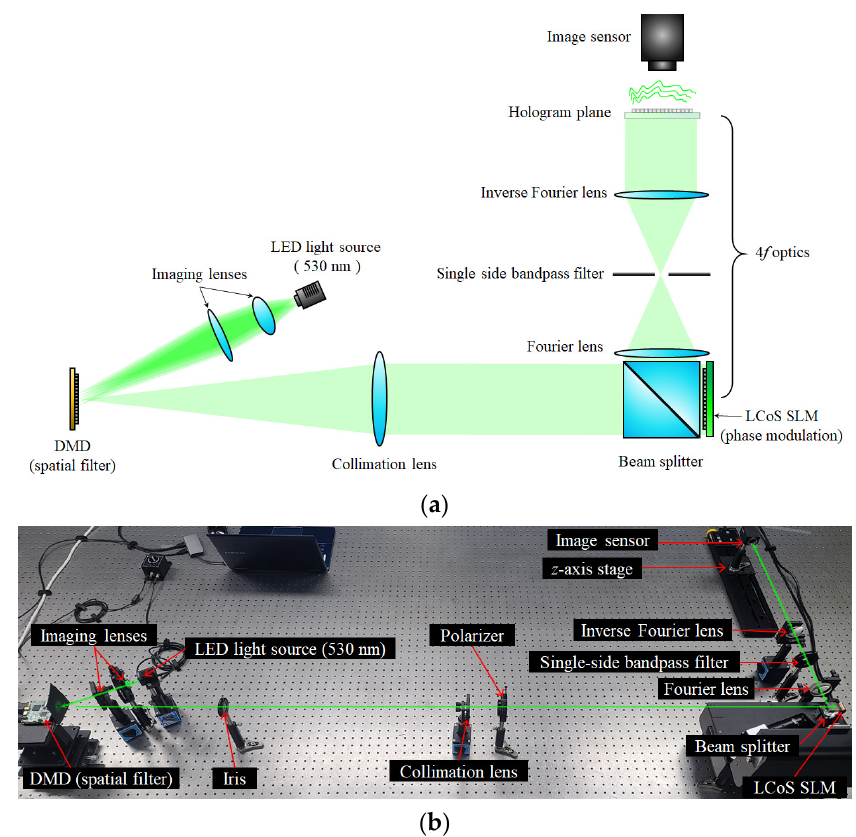
Figure 7. Experimental setup obtaining the optimal spatial coherence of the LED. ( a ) The optical scheme and ( b ) the experimental